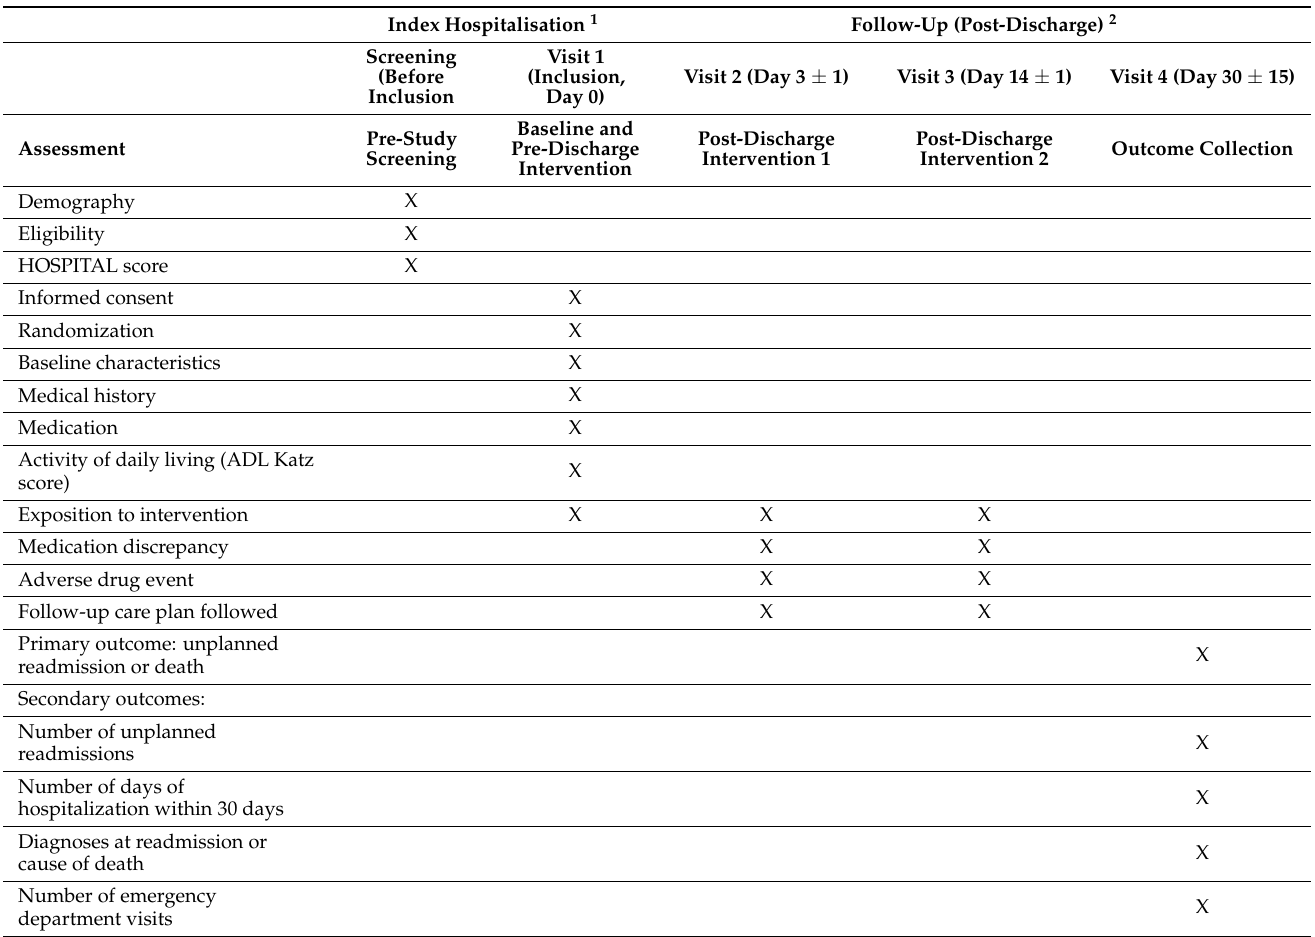
Table 3. Study procedures and assessments pre and